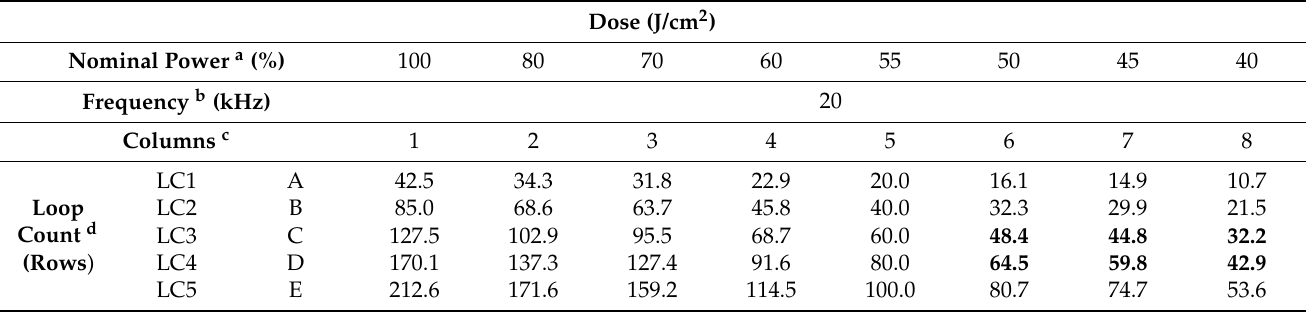
Table 2. Dose values as a function of the loop counts and the percentage of the nominal laser power set in the instrument.